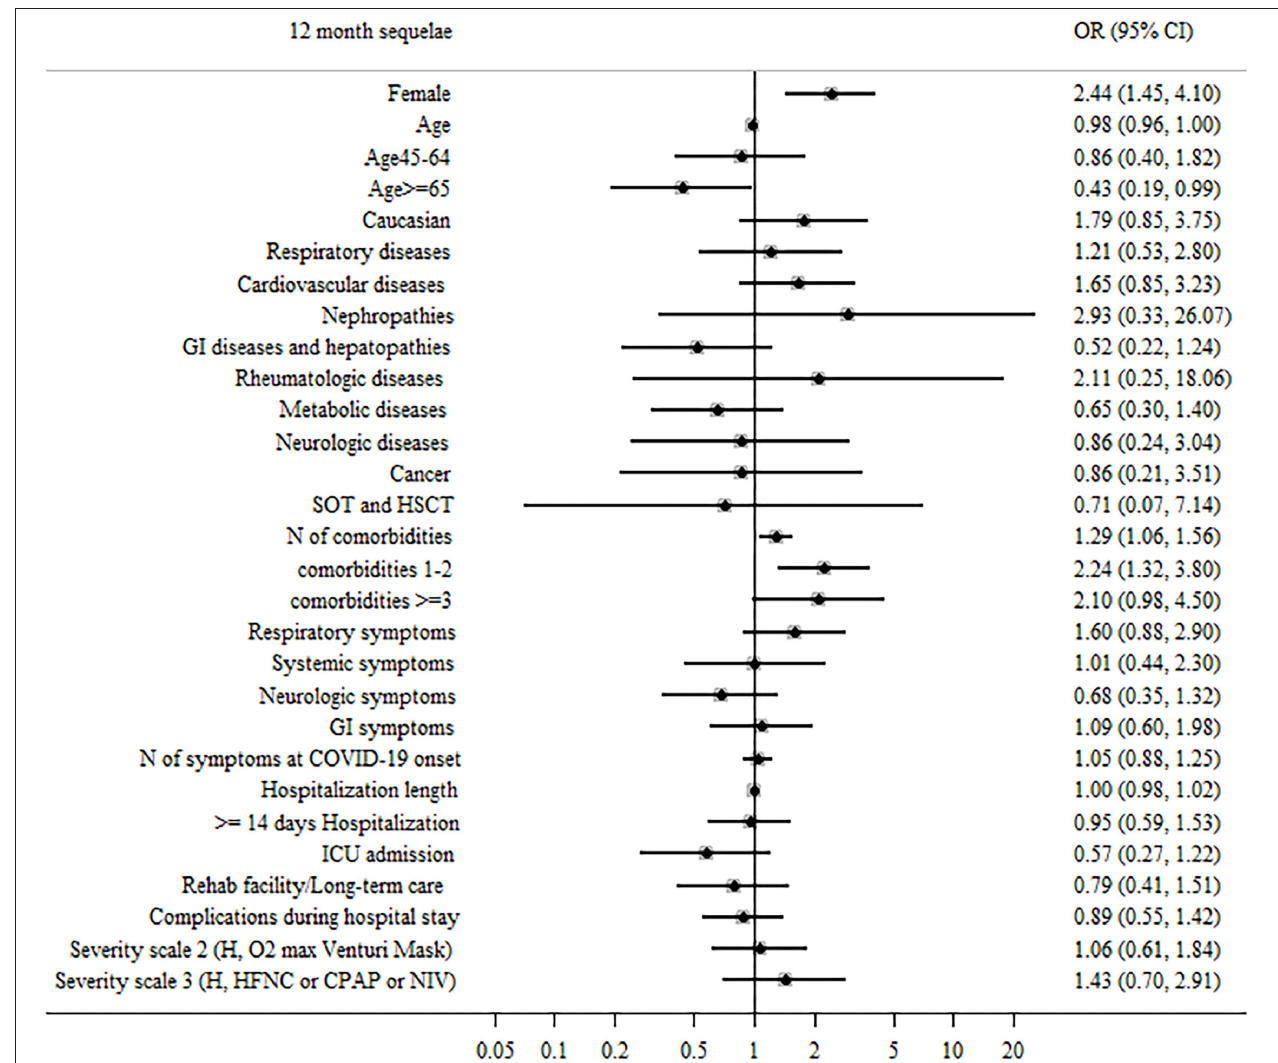
FIGURE 3 | Patient factors associated with ≥ 2 sequelae or persistent symptoms during the 12 months after hospital discharge in surviving patients.